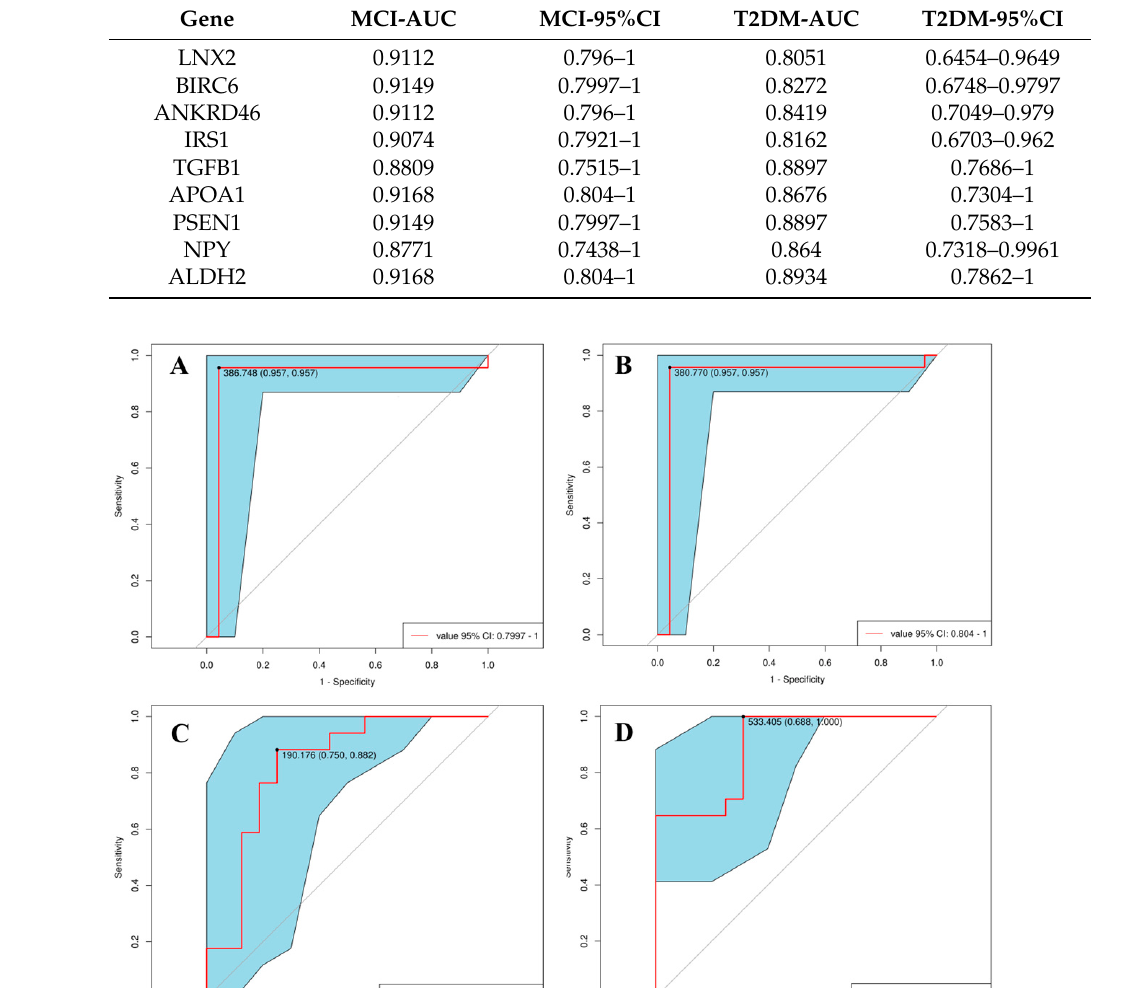
Table 4. The top 10 and bottom 10 potential compounds.